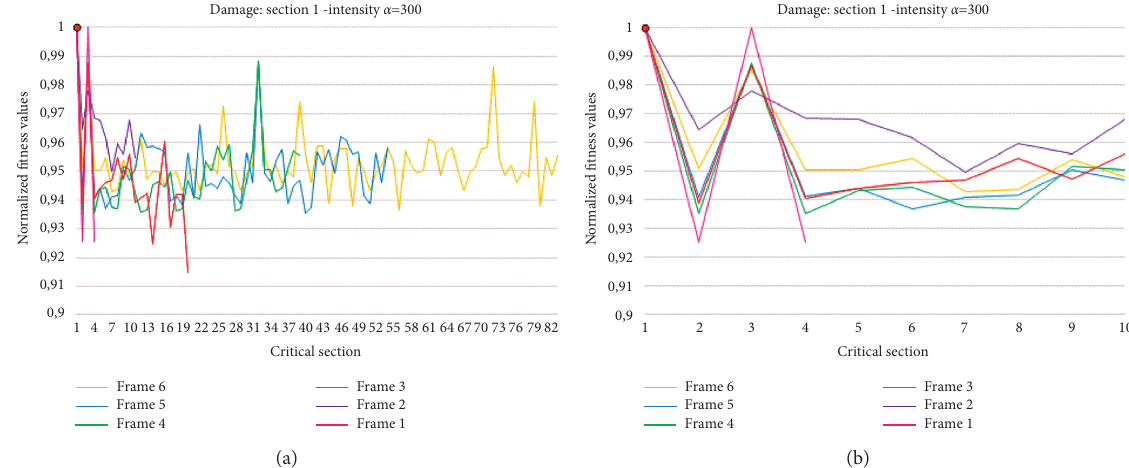
Figure 11: Normalized fitness values for damage with intensity α � 300 located in section 1 (a) and a zoom (b) for all the analysed equal to the distance between two floors). Sections for which the fitness has been calculated are col- oured in red.